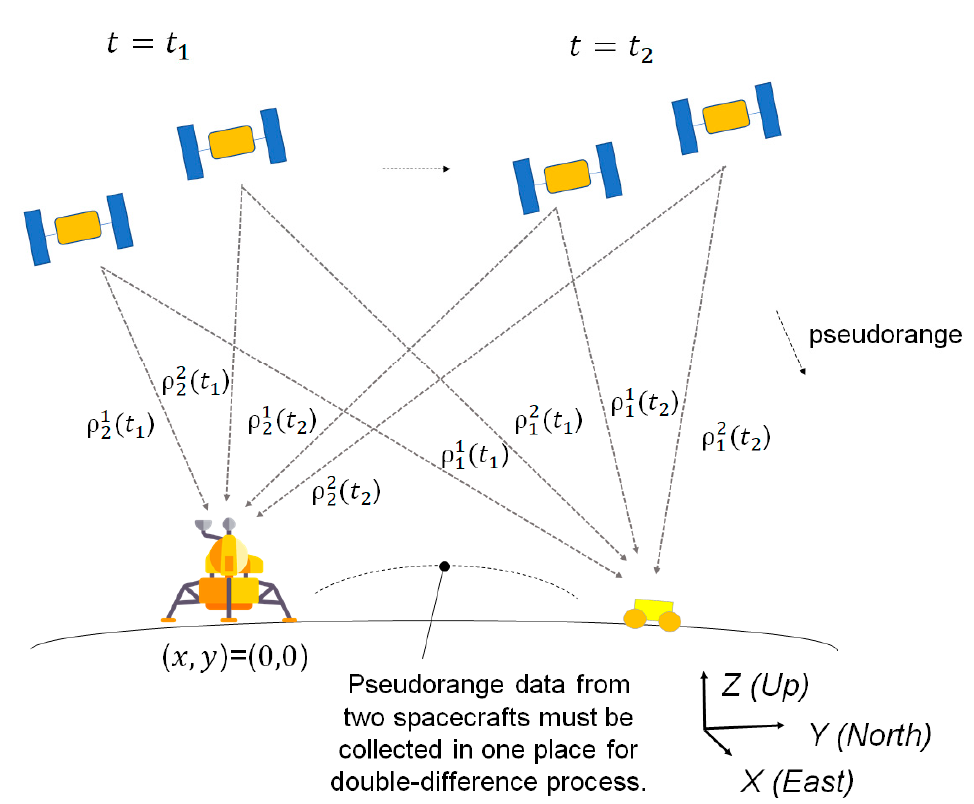
Figure 1. Overview of the multi-epoch double-differenced pseudorange observation (MDPO) method.